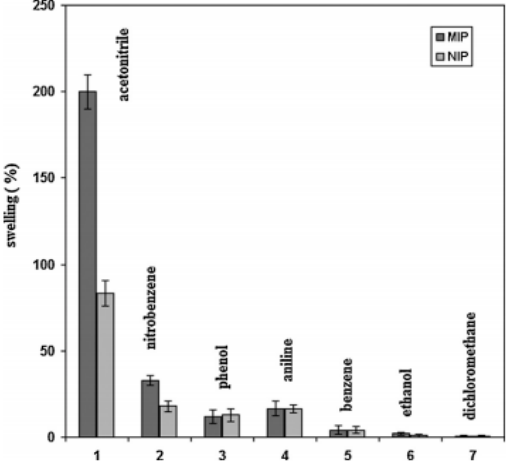
Figure 7. Comparison of the swelling intensities of the MIP and NIP in acetonitrile (1 mL) and other organic compounds (1 mM of them in acetonitrile, 10 mL) [31].